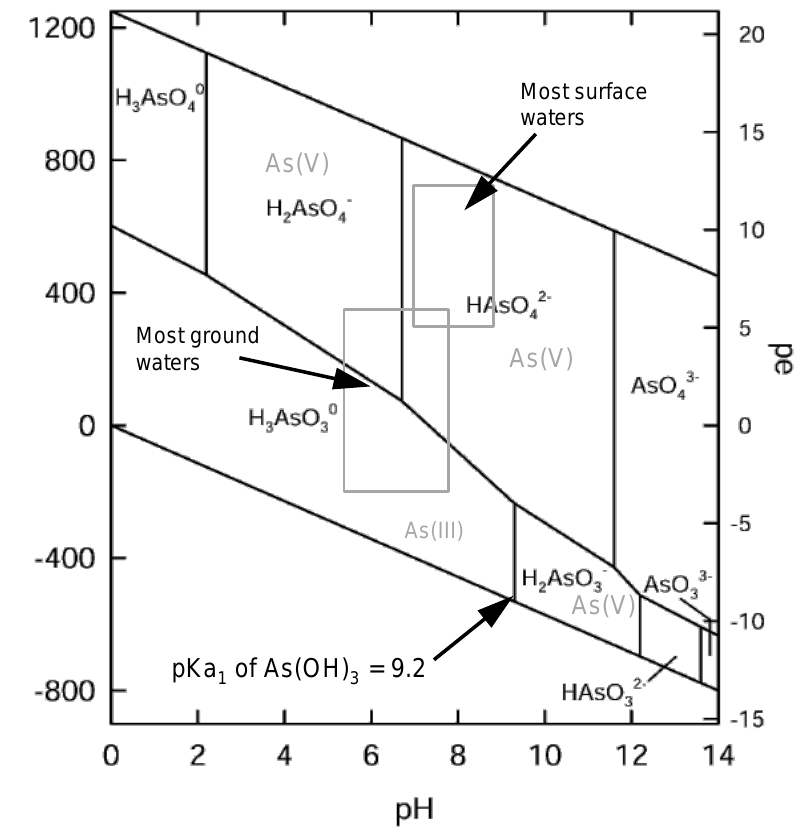
Figure 1. Eh-pH chart of aquatic arsenic species under oxic conditions at 1 bar and 25 °C. Reprinted and adapted from [9] with permission from Elsevier.